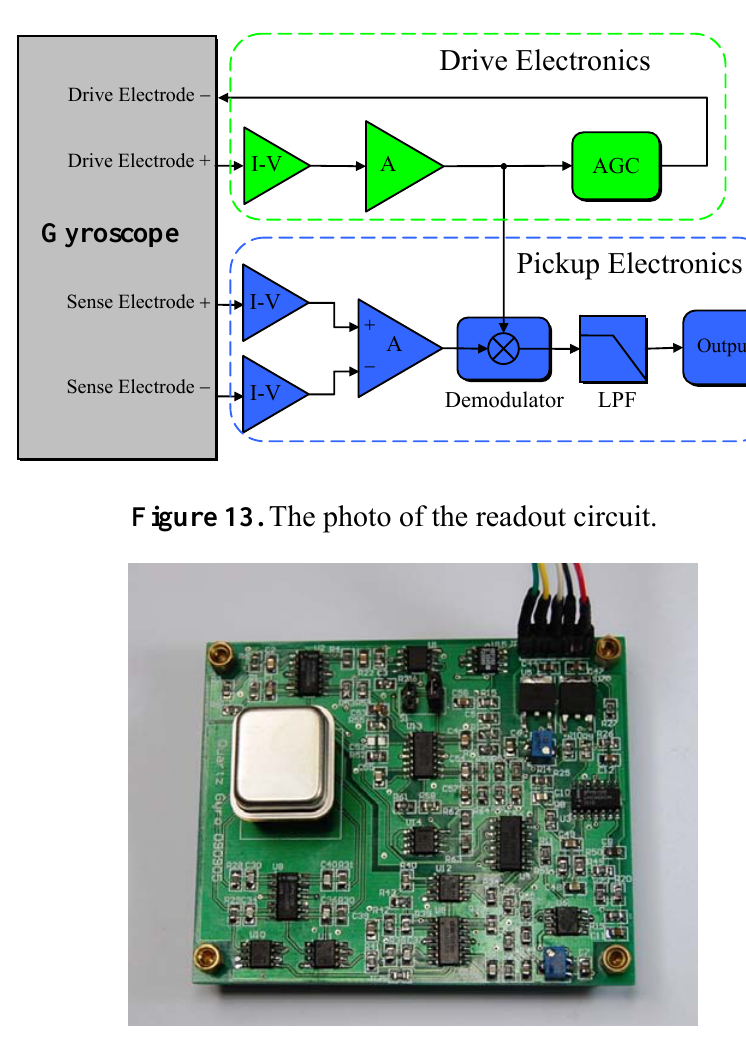
Figure 12. The block diagram of the readout circuit.